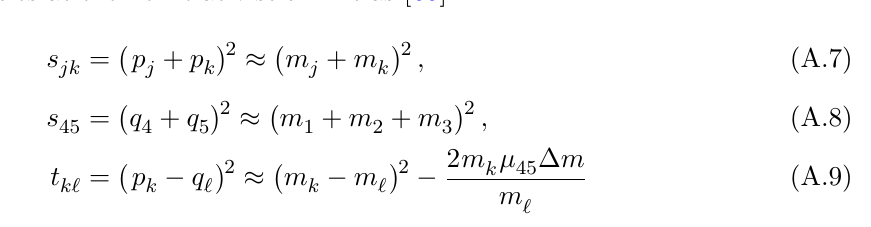
+ p + p → q + q , in the CM frame 1 2 3 4 5